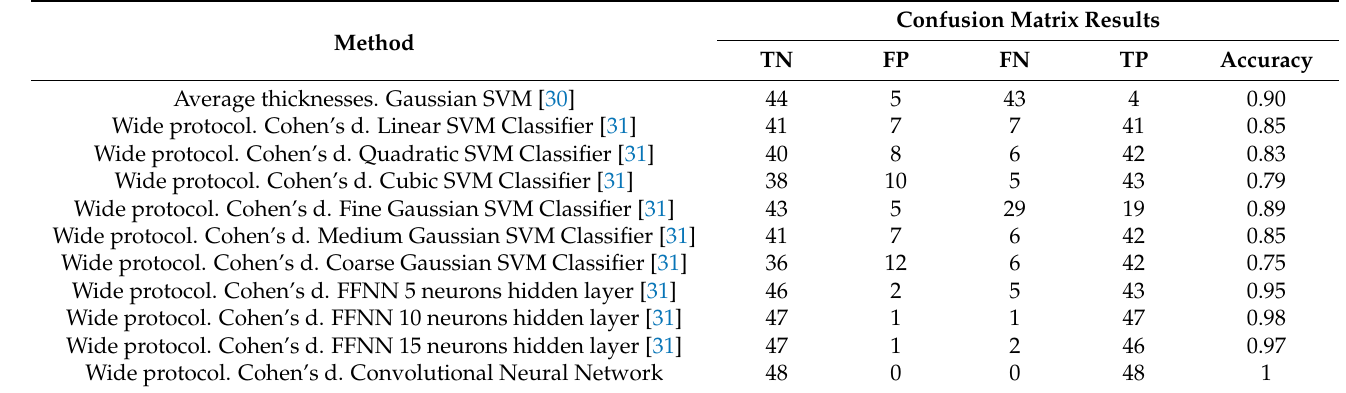
Table 2. Comparison of the results of several methods using the same OCT database. TN: true negative, FP: false positive, FN: false negative, TP: true positive, FFNN: feedforward neural network, SVM: support vector machine. Confusion Matrix Results Method TN FP TP